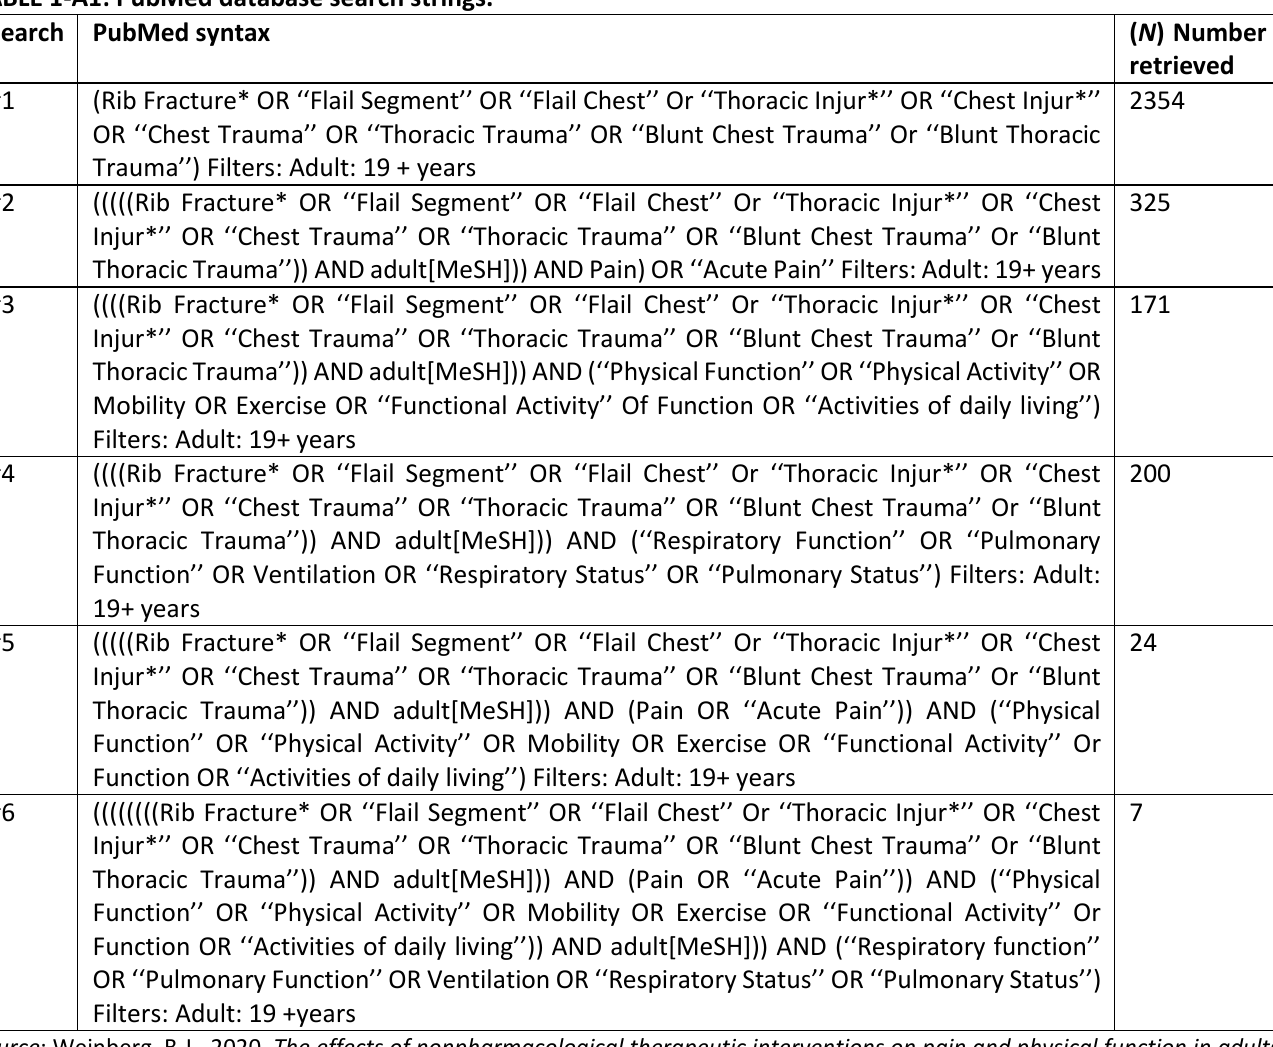
TABLE 1-A1: PubMed database search